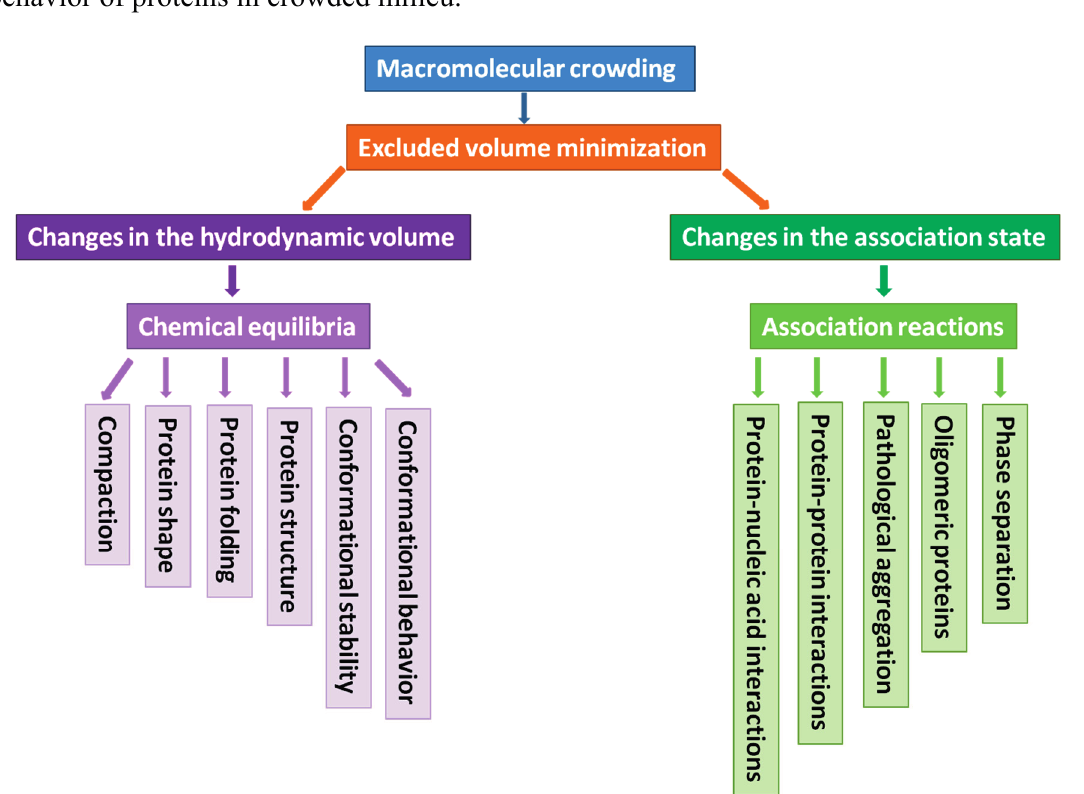
Figure 1. Schematic representation of the potential effects of excluded volume on the behavior of proteins in crowded